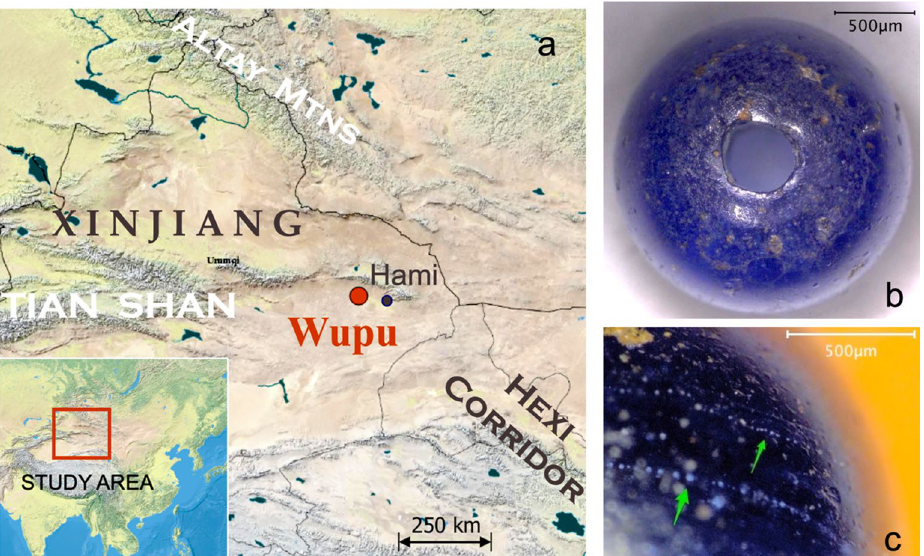
Figure 2. Information about the Wupu bead. ( a ) Wupu is located in eastern Xinjiang, near the eastern Tian Shan range. ( b ) The bead from Wupu. ( c ) Close-up view, chains of bubbles trapped in the glass are indicated. The map in ( a ) was created with QGIS 3.10 (https ://qgis.org), based on the basemap of World Physical Map (http://goto.arcgi sonli ne.com/maps/World _Physi cal_Map) with World Reference Overlay http://goto.arcgi